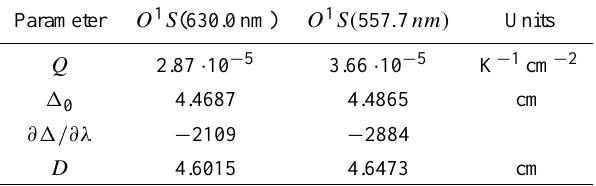
Table A2. Temperature error produced by using 1 0 instead of D Emission Path